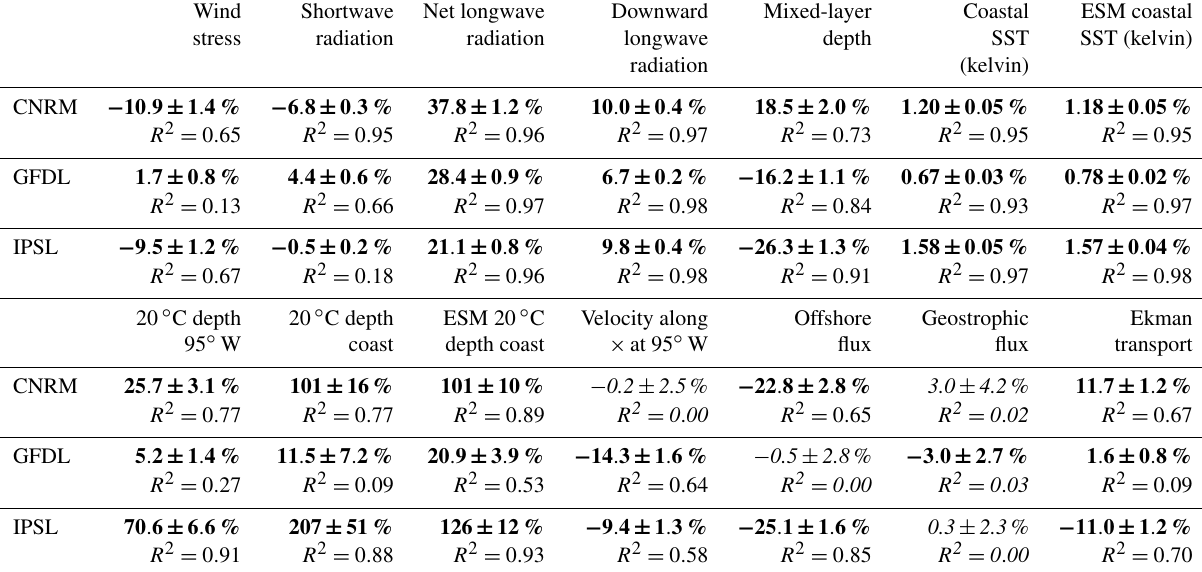
Table 3. Differences (in percent) between 2100 and 2006 (with respect to values in 2006) computed from RCM and ESM linear trends and R 2 for wind stress, shortwave radiation, net longwave radiation, mixed-layer depth, coastal SST for RCM and ESM, 20 ◦ C isotherm depth at the coast for RCM and ESM and at 95 ◦ W for RCM, zonal velocity at 95 ◦ W, and offshore and geostrophic fluxes. Bold font indicates significant values with a 90% level of confidence. Italic font indicates values below the 90% level of